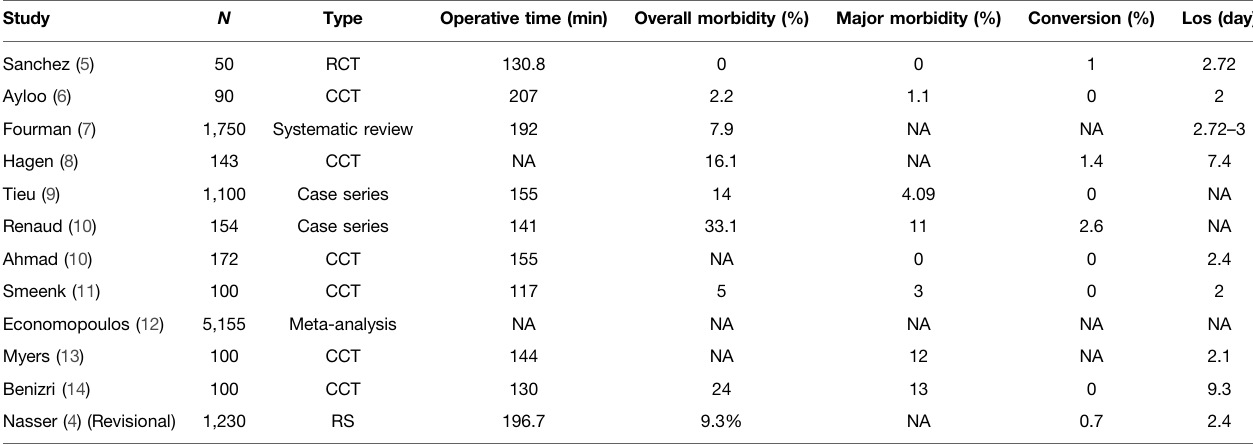
TABLE 2 | Literature review of robotic Roux-en-Y Gastric